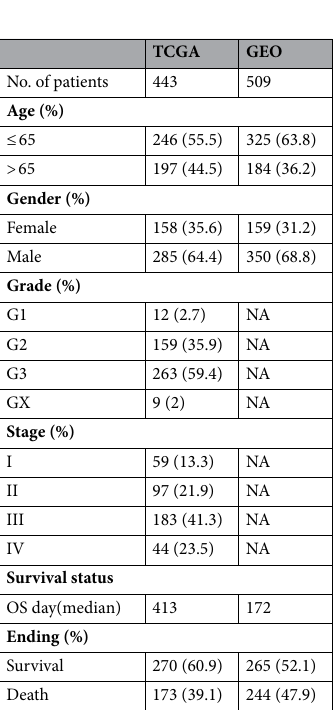
Table 1. Clinical characteristic of the GC patient used in this study. NA not